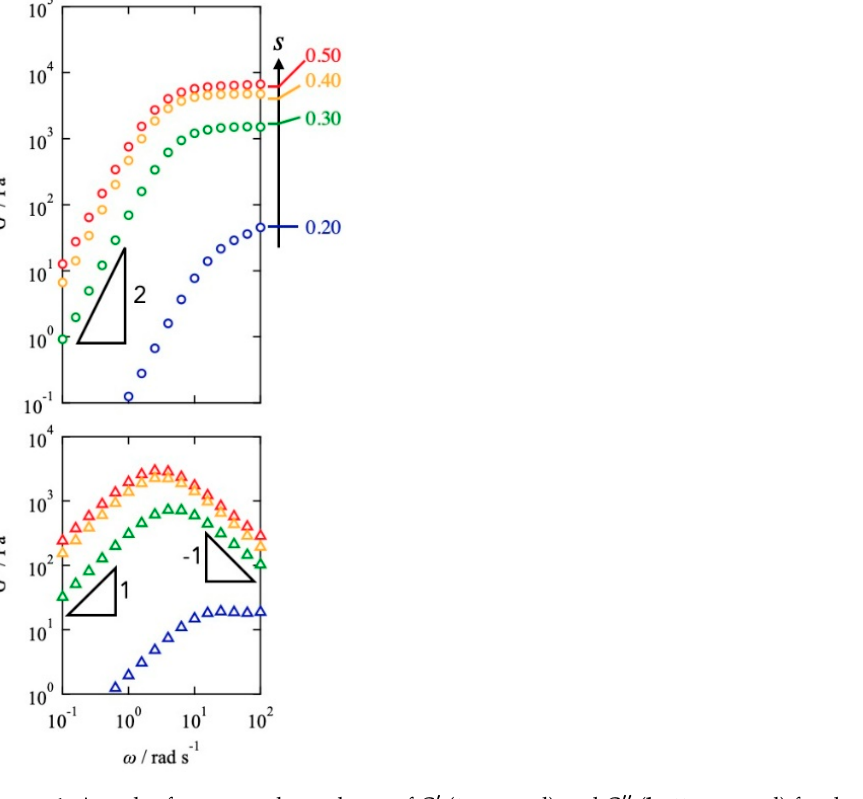
Figure 1. Angular frequency dependence of G ′ (top panel) and G ″ (bottom panel) for the Tetra-PEG slimes with various s at 30 °C.